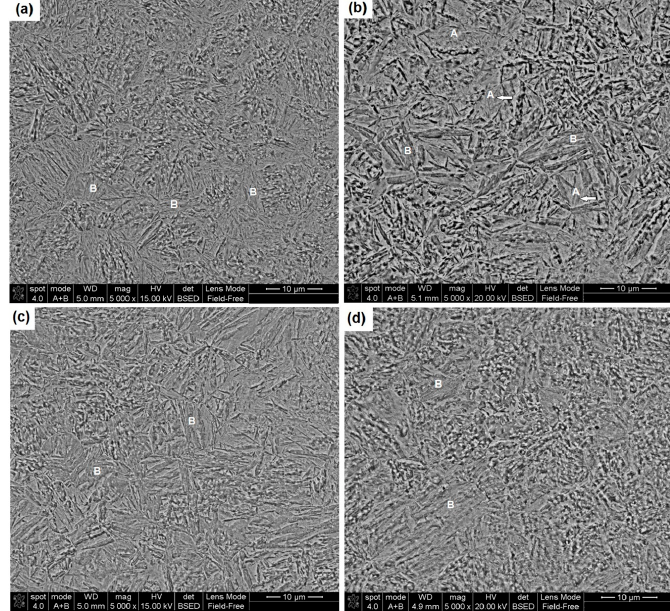
Figure 4. Low-magnification FEG-SEM images of samples austempered for different durations: ( a ) 10 min; ( b ) 20 min; ( c ) 40 min; and ( d ) 80 min. Note the growth of bainitic ferrite.